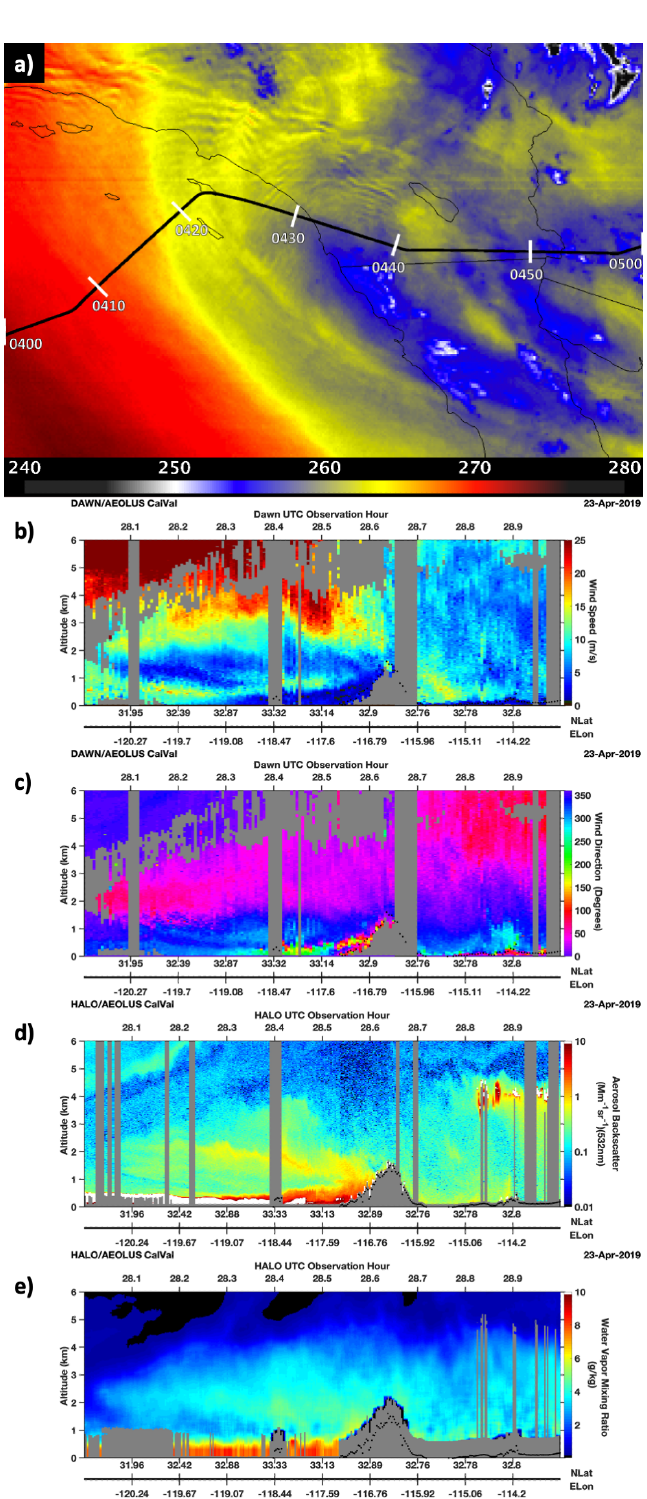
Figure 8. (a) GOES 7.3µm water vapor brightness temperature (in kelvin) at 0426UTC on 23 April 2019. The color scale of this image has been compressed relative to that shown in Fig. 1 to accentuate mountain wave patterns along the flight track (bold black line). (b, c) DAWN wind speed and direction along the 1h flight period shown in the GOES image. The wind speed color scale has also been compressed to accentuate wind speed variations associated with the mountain waves. (d) HALO 532nm aerosol backscatter. (e) HALO water vapor mixing ratio colorized with a linear scale to accentuate